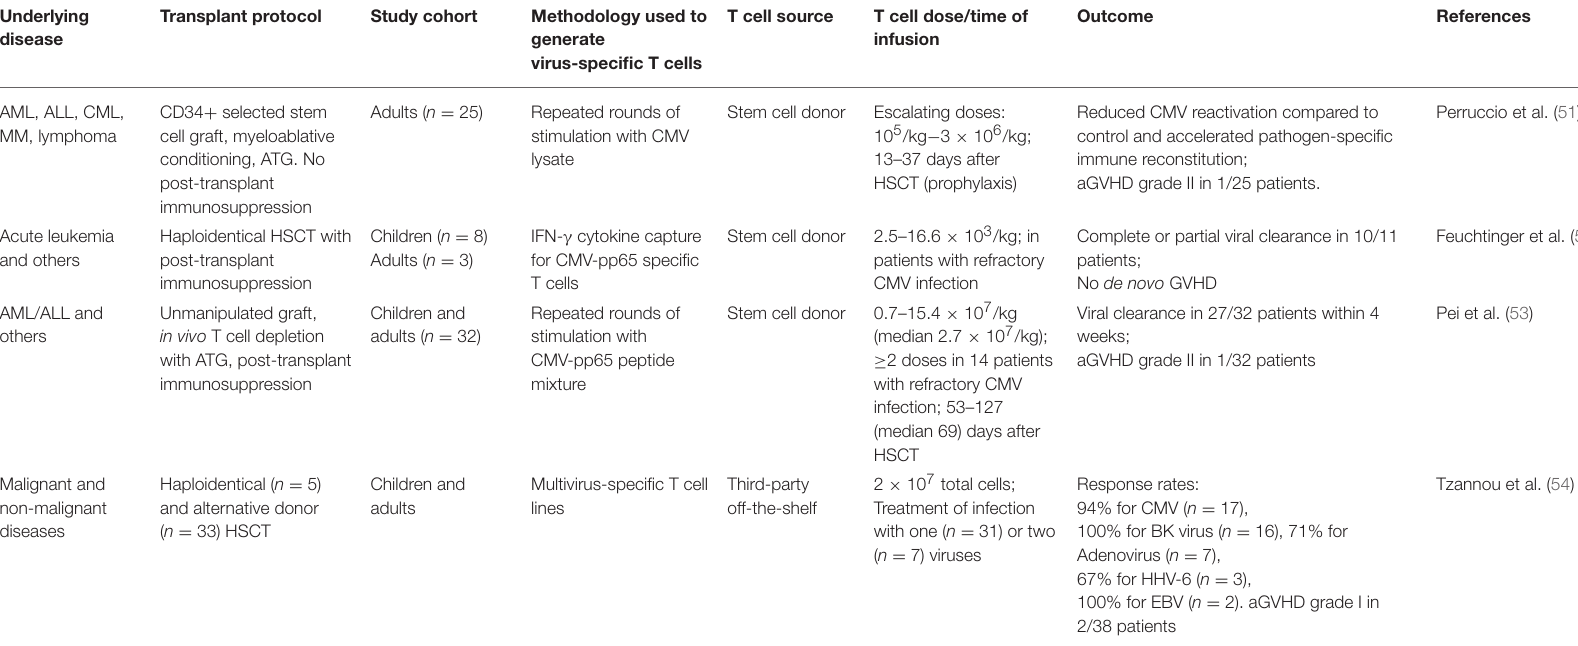
TABLE 2 | Selected studies using virus-specific T cells that enrolled predominantly haploidentical HSCT